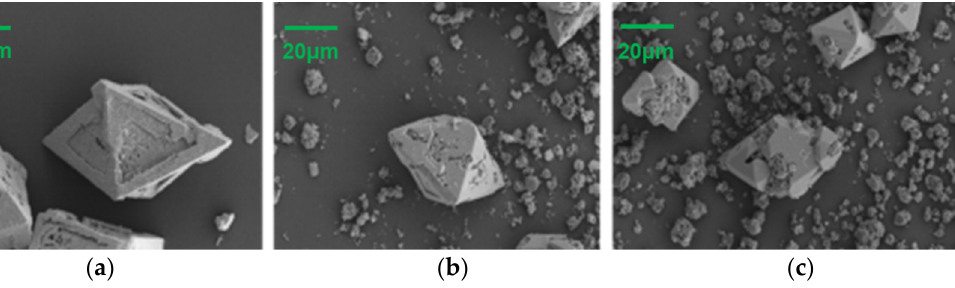
Figure 2. SEM of Mg 2+ -doped LiYF 4 :Yb 3+ /Ho 3+ UCMPs. ( a ) Mg 2+ =0 mol%, ( b ) Mg 2+ =8 mol%, ( c ) Mg 2+ =12 mol%.